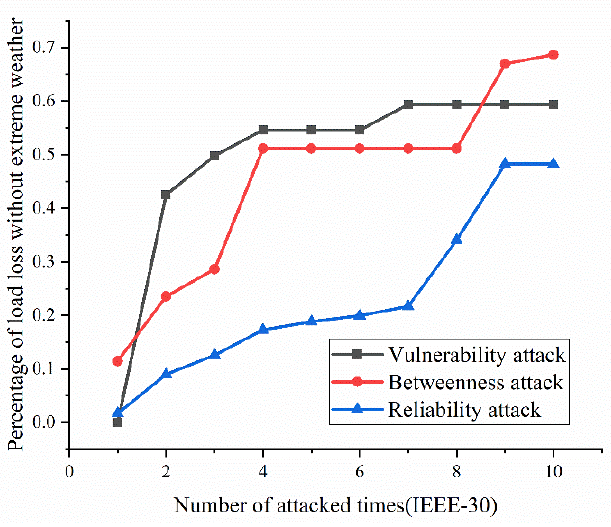
Figure 17. Load loss ratio of IEEE-30 bus system without extreme weather.